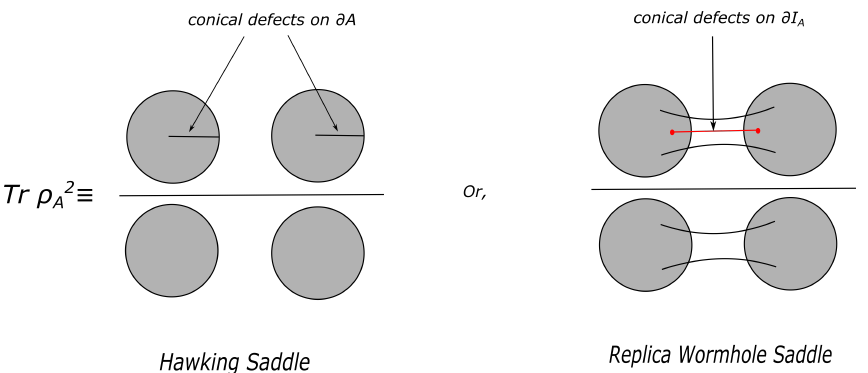
Figure 2: Schematic for the path integral representation of the replicated manifold for the generalied Renyi entropy. Figure modified from [ 35